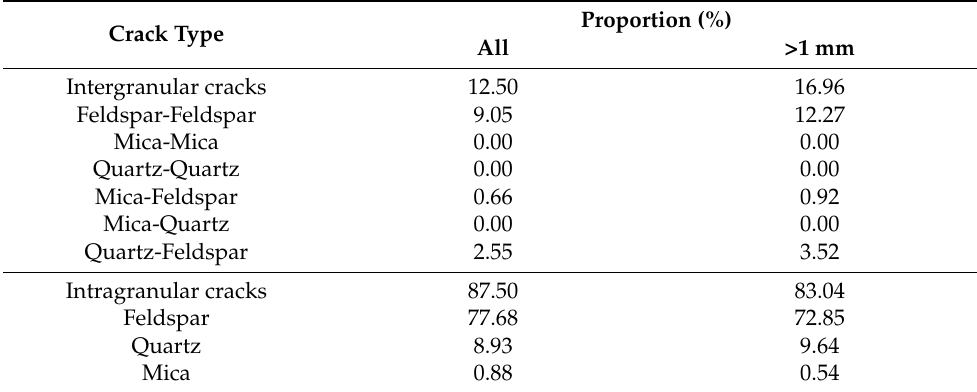
Table 2. Proportions of the various inter- and intragranular cracks in the particle bed of the test with 20 MPa